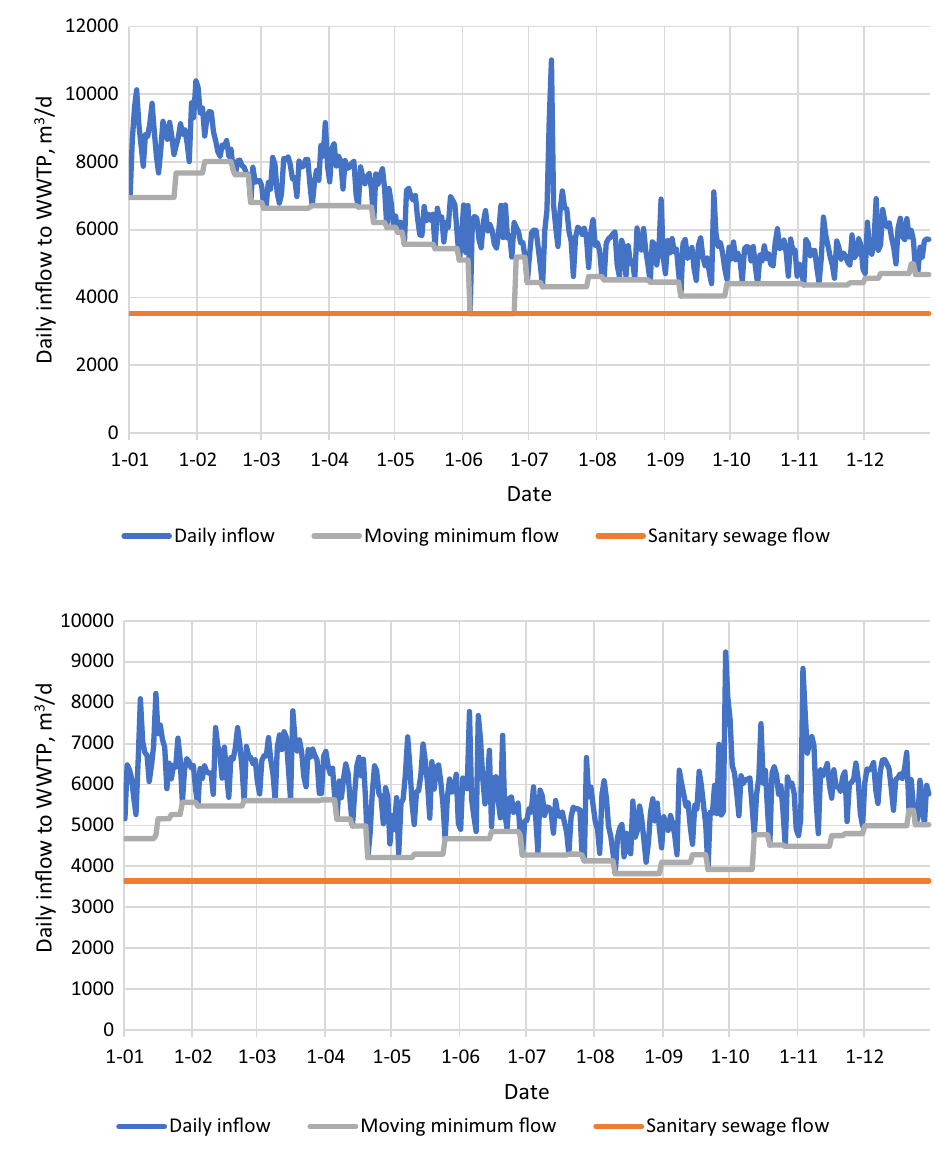
flow plotted on a daily inflow diagram in the year 2018